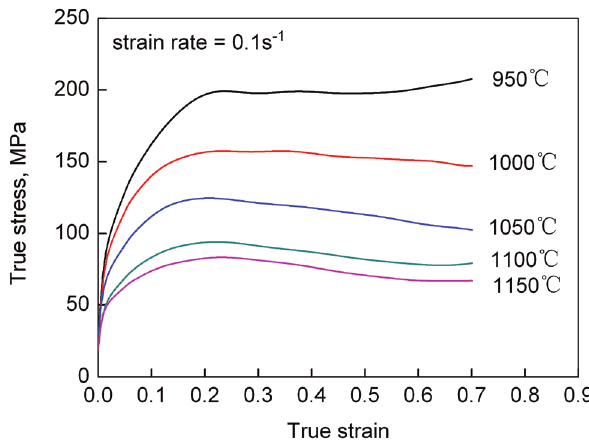
Fig. 1: Flow stress curves for specimens deformed at 0.1 s − 1 for different deformation